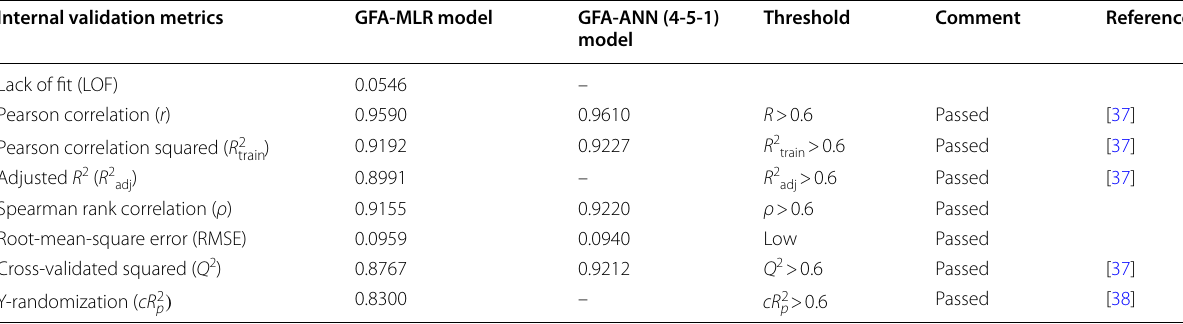
Table 2 Internal validation of the 2D-QSAR models